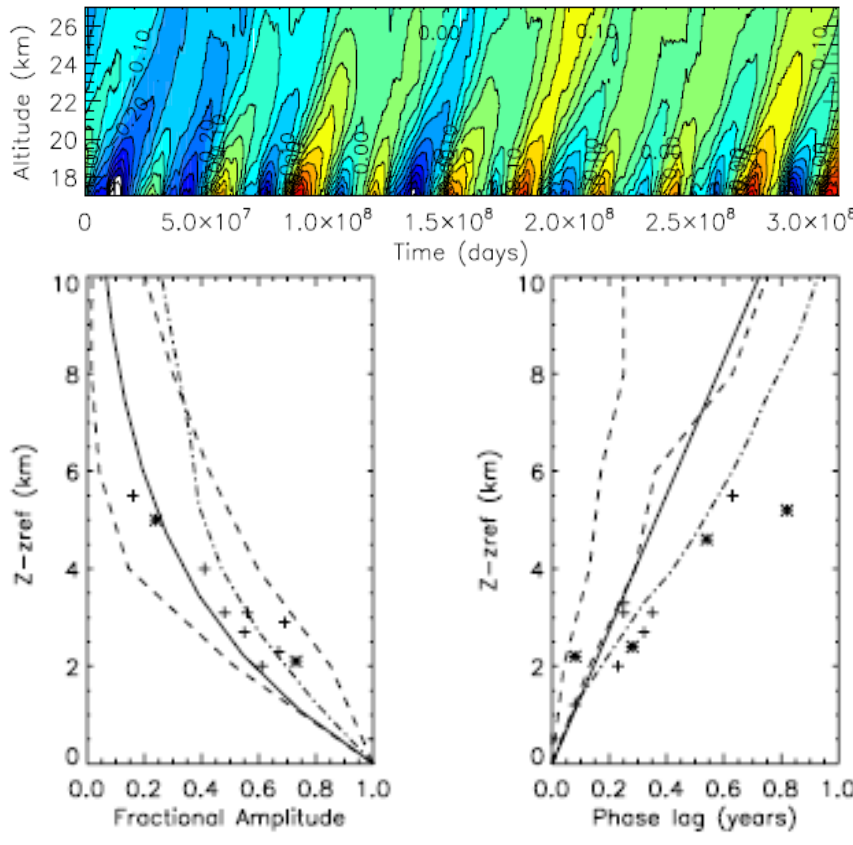
Fig. 5. Time-altitude cross section of total hydrogen H (=2CH 4 +H 2 O) simulated by LMDz-REPROBUS for the 1986–1995 period, shown as the deviation from the mean time profile, averaged between 12S and 12N (top). Equatorial profiles of the amplitude attenuation A(z) (bottom left) and the phase lag τ(z) (bottom right) of the tape recorder in the lower and middle troposphere derived from in situ CO 2 (crosses), in situ H (stars) and HALOE H (dashed-dotted line) as reported in Hall et al. (1999) and from the analysis of the simulated H anomalies field shown in the upper panel (solid black line). The altitude (zref) where the amplitude attenuation and the phase lag are equal to 1 and 0, respectively, is at 16km for the observations and 17km for the model. Note that our results are different than in Eyring et al. (2006) (see text for more